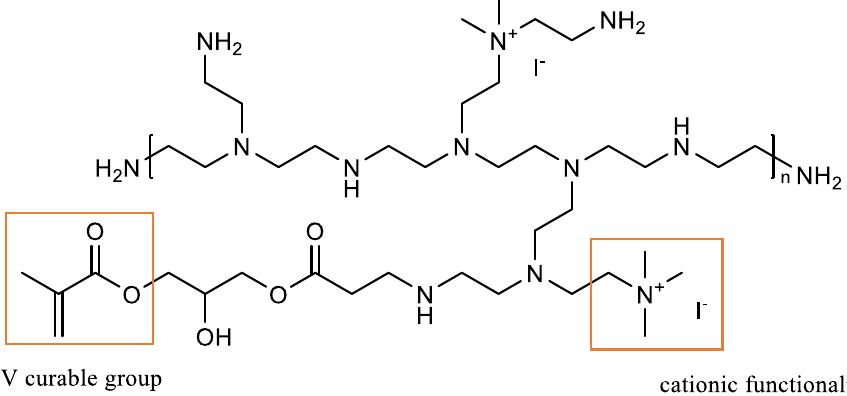
Figure 11. Chemical structure of modified UV-curable cationic poly(ethyleneimine) (Quv-PEI).